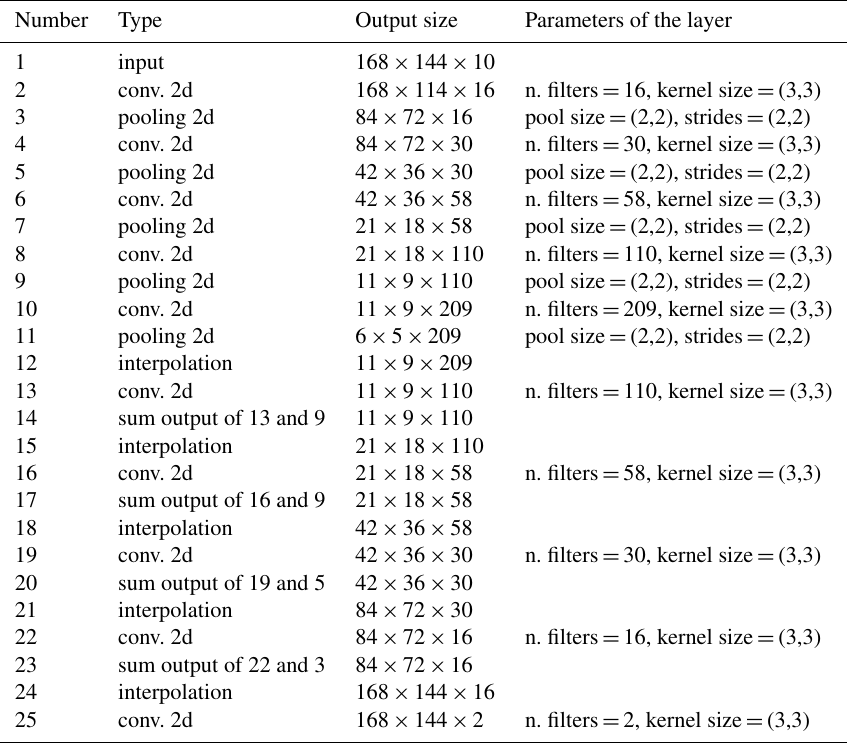
Table 1. Layers of the neural network for the gridded datasets. Note that every convolution is followed by a RELU activation function. Number Type Output size Parameters of the layer 1 input conv.